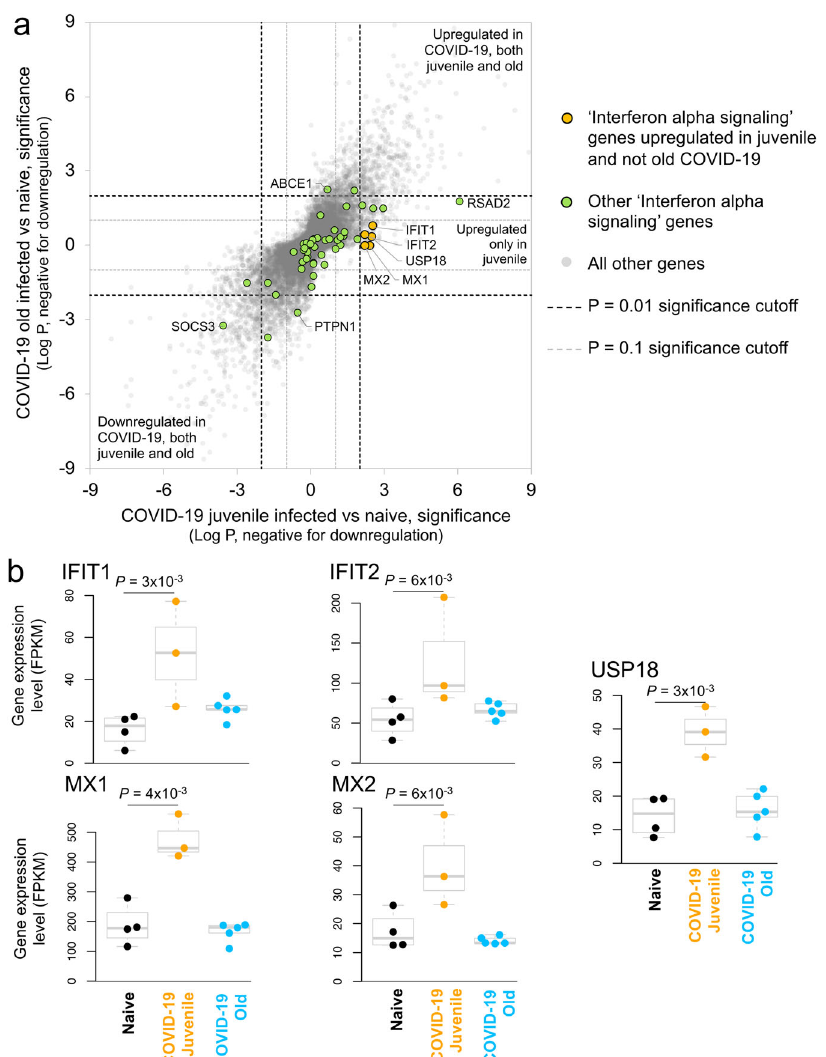
Fig. 5 Interferon alpha signaling genes are signi fi cantly upregulated in juvenile SARS-CoV-2-infected macaques but not old SARS-CoV-2-infected macaques. a Differential expression signi fi cance values for genes from the “ Interferon-alpha signaling ” (R-HSA-909733) pathway, in both the juvenile vs naive and old vs naive comparisons. Included are signi fi cance values for all genes (gray), pathway genes signi fi cantly upregulated in juvenile but not old (orange) and other pathway genes (green). P value cutoffs (0.01 and 0.1) are indicated with dashed lines. b The relative expression levels (FPKM) for the fi ve “ interferon-alpha signaling ” genes belonging to this gene set are shown. P values represent FDR-corrected signi fi cance values from